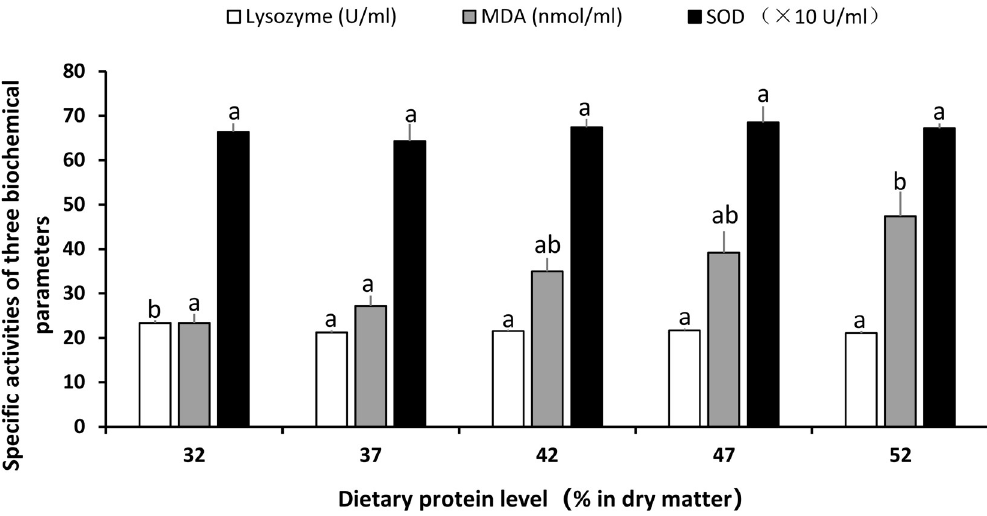
Fig 3. The three non-specific immune parameters in plasma of Culter mongolicus fed with varying dietary protein levels. Data presented are mean ± SE, different letters on the top of same shape bars means significantly different ( p < 0.05).